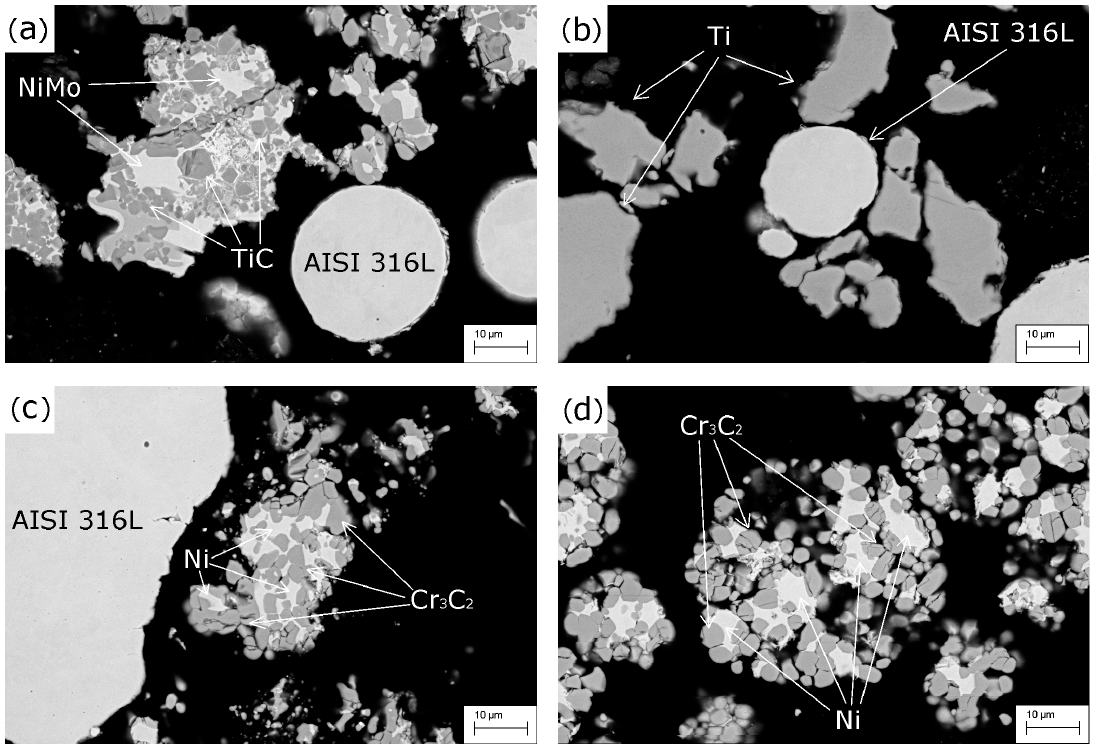
Figure 1. Particle structure of: ( a ) MAS (TiC–20%NiMo) + AISI 316L; ( b ) Ti + C + AISI 316L; ( c ) MAS (Cr 3 C 2 –20%Ni) + AISI 316L; and ( d ) Cr 3 C 2 –25%NiCr (Amperit).